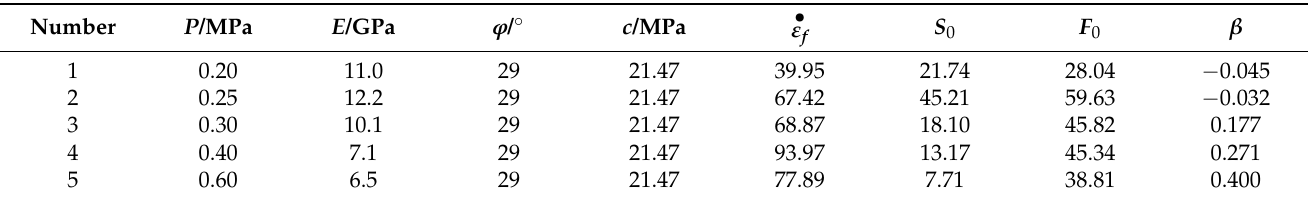
Table 3. Parameters of the single-impact dynamic constitutive model of mudstone.